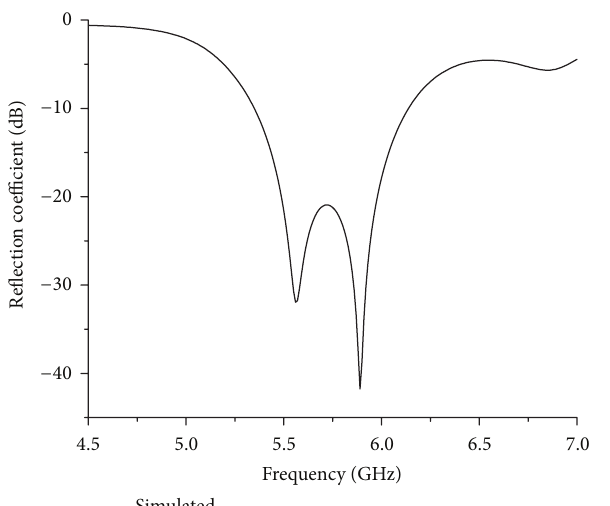
Figure 6: The simulated directivity as a function of frequency for the square patches antenna